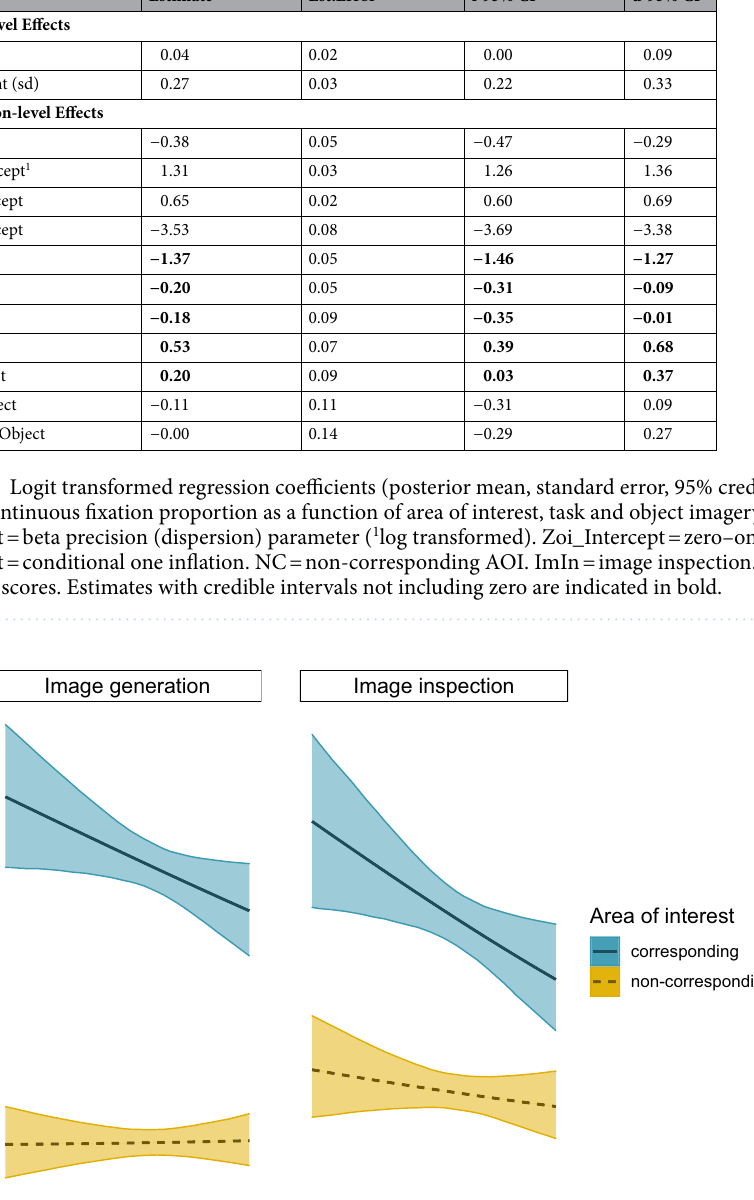
Eye movements to absent objects and spatial imagery ability. In two additional models, spatial imagery scores (OSIQ spatial imagery scale, IST) were included instead of the OSIQ object imagery scores. Posterior draws indicated that the difference between the corresponding and the non-corresponding AOIs was not moderated by the OSIQ spatial imagery score, β NC : Spatial = .04 ; SE = .07 ; CI = [ − .09 ; .17] nor by performance on the IST, β NC : IST = − .2 ; SE = .44 ; CI = [ − 1.08 ; .62] . Eye movements to the location where the objects were previously encoded do not depend on individual differences in spatial imagery abilities. Parameters of the additional mod- els (including OSIQ spatial imagery scale or IST) are provided in the Supplementary material. Spatially constraint fixations. Participants did not re-fixate any of the predefined AOIs in about two thirds of the trials. The estimated probability of a binary outcome (i.e., fixating the predefined AOIs in either 0% or 100% of the entire trial duration) was 66%, zoi _ Intercept = .65 ; SE = .02 ; CrI = [.60 ; .69] . Out